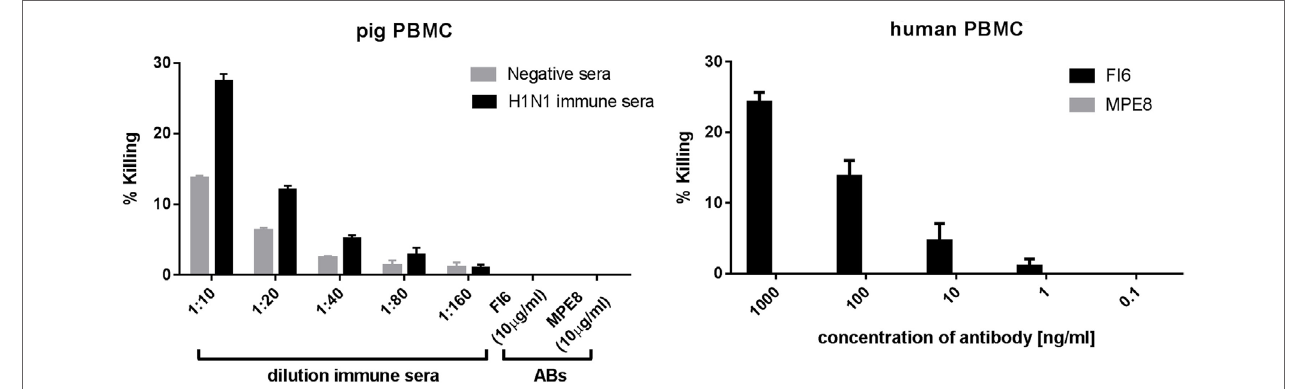
FigUre 6 | Antibody-dependent cytotoxicity (ADCC) activity of pig and human PBMC. Madin–Darby canine kidney cells expressing H1 HA were incubated with FI6, MPE8, immune, or normal pig sera in the presence of either pig or human PBMC. ADCC was measured in triplicate by lactate dehydrogenase release. FI6 and MPE8 mAbs were used at 10 µg/ml (left panel) or at a concentration range from 0.1 to 1,000 ng/ml (right panel). Representative of three